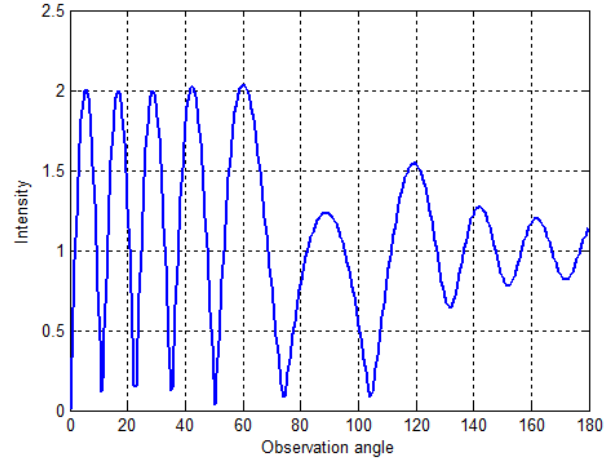
FIGURE 7. The total electric